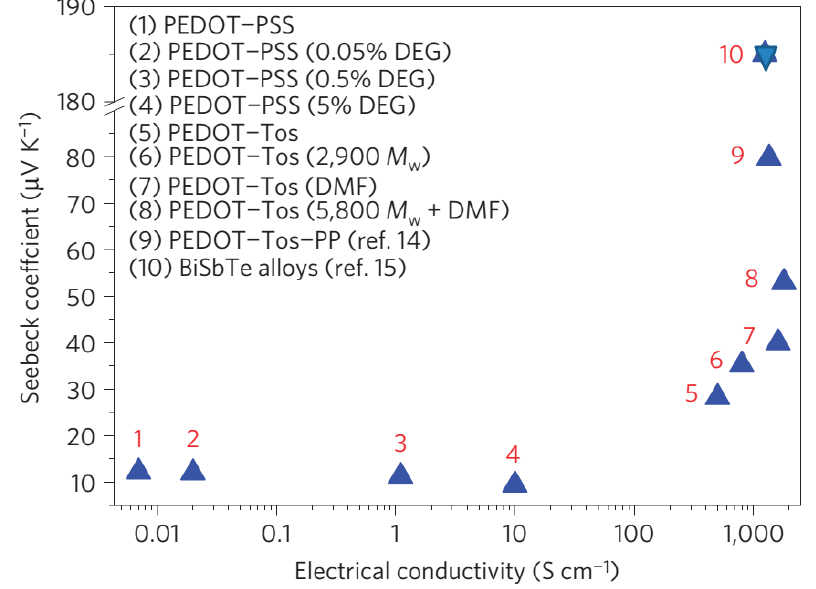
Figure 5. Seebeck coefficient versus electrical conductivity of various PEDOT derivatives including pristine PEDOT/PSS and diethylene glycol (DEG)-containing samples, chemically polymerized PEDOT/Tos as well as three VPP PEDOT/Tos samples with triblock copolymers PEG–PPG–PEG with different Mw. Reproduced with permission from [48]. Copyright 2014 Nature Publishing Group. (PEG = polyethylene glycol, PPG = polypropylene